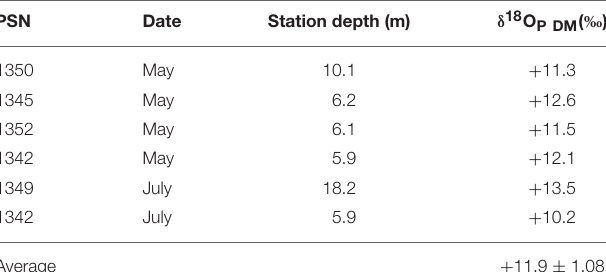
TABLE 2 | Oxygen isotopic composition of phosphate collected δ 18 O P in incubations with dreissenid mussels ( δ 18 O P_DM ) harvested from eastern Lake Erie in 2013 and